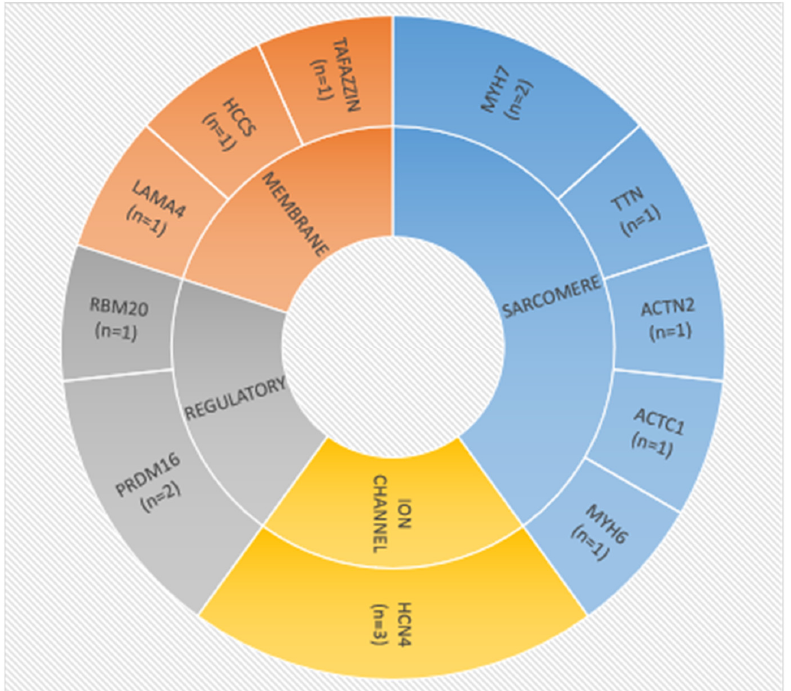
Figure 2. Distribution of LVNC ‐ related genes identified in this study. The number of families carrying putative disease ‐ causing molecular variants in particular genes are in brackets. The inner circle indicates the category of proteins involved.